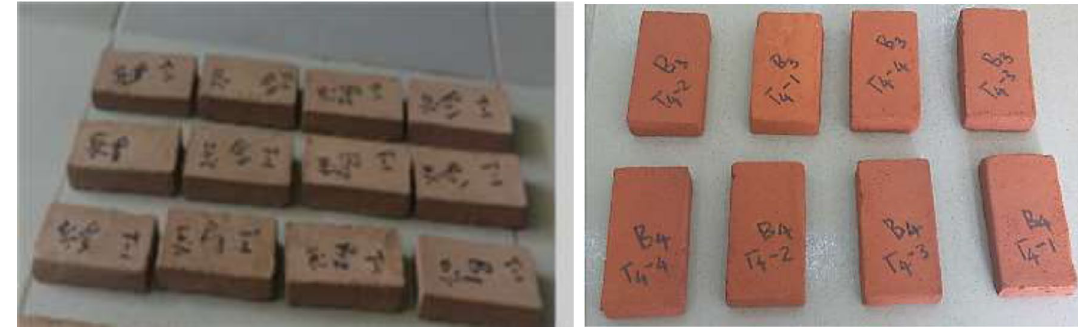
Fig. 9 Bricks’ colour transformation after a sintering